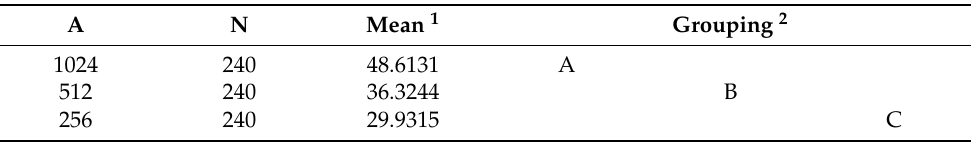
Table 9. Tukey post-hoc analysis for A and perceived difficulty. The perceived difficulty was positively related to A . A shorter A was associated with lower perceived difficulty.